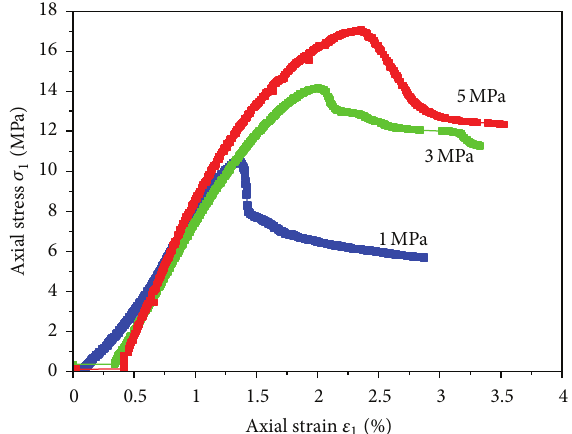
Figure 6: Stress-strain relations of mudstone samples under triaxial compression.